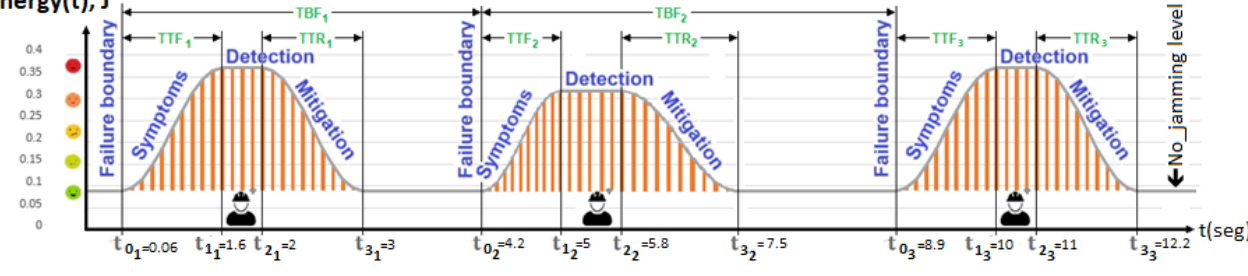
Figure 20. MTBF, MTTF y MTTR calculation.